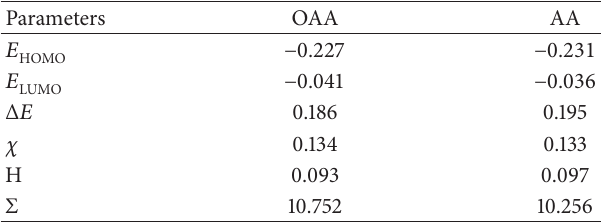
Table11:CalculatedquantumchemicalparametersofO-Anisicacid (OAA) and Anisic acid (AA) derivatives.